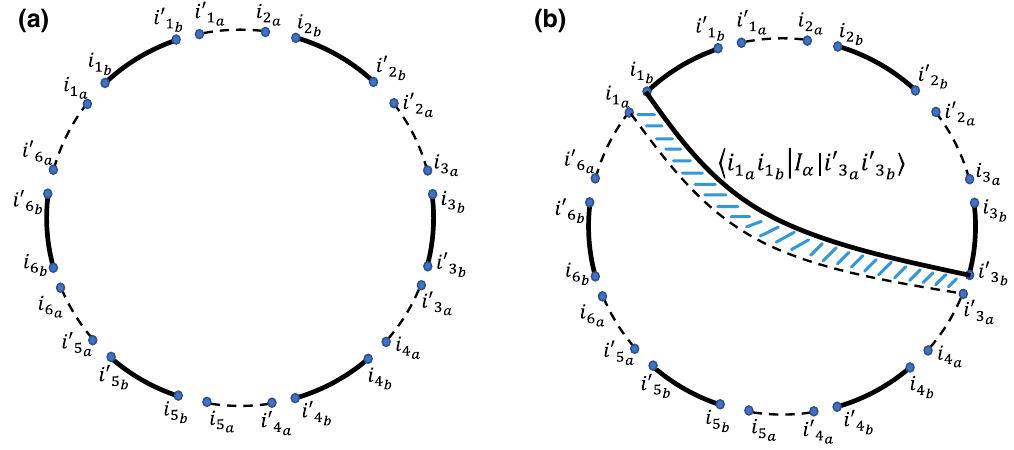
(τ) , coming from the factor in the first line of Eq. (46), for n = 6. In (b), we n